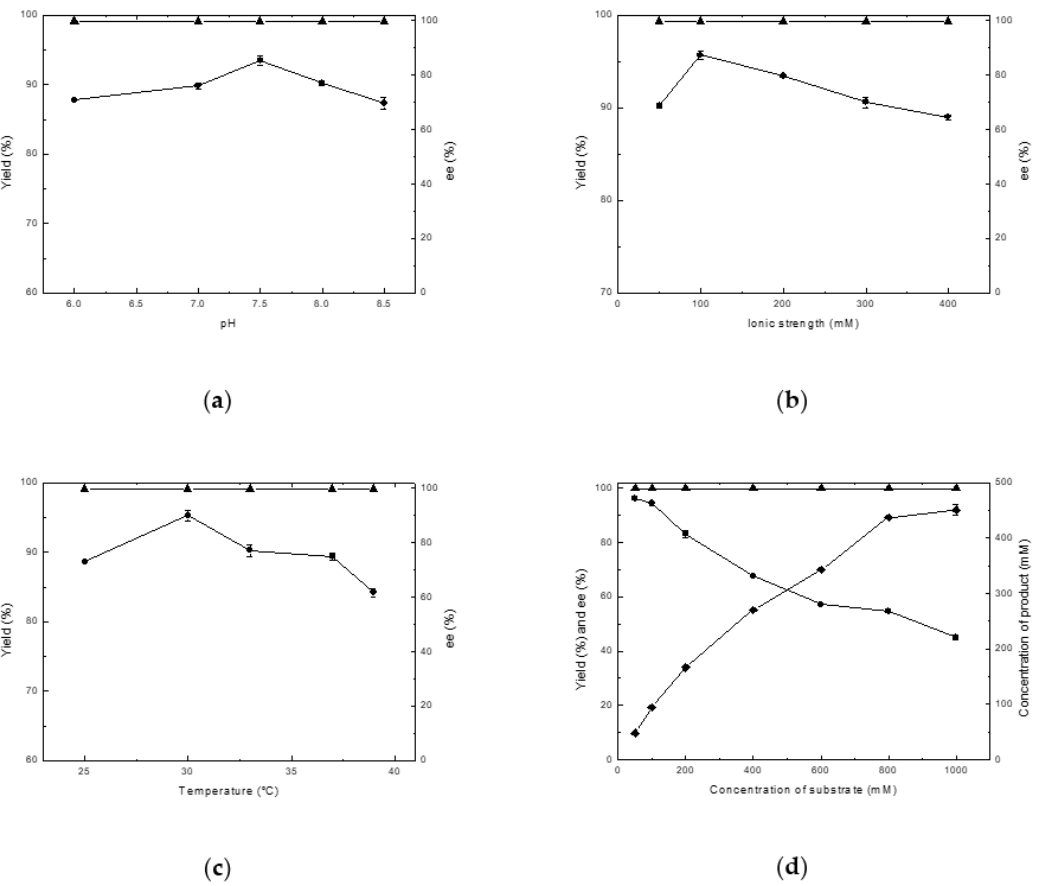
Figure 5. Effects of pH. ( a ) Ionic strength; ( b ) temperature ( c ) and substrate concentration ( d ) on the asymmetric reduction of 4-(trifluoromethyl)acetophenone. Symbols: ( ● ) Yield, ( ▲ ) ee and ( ◆ ) product concentration.